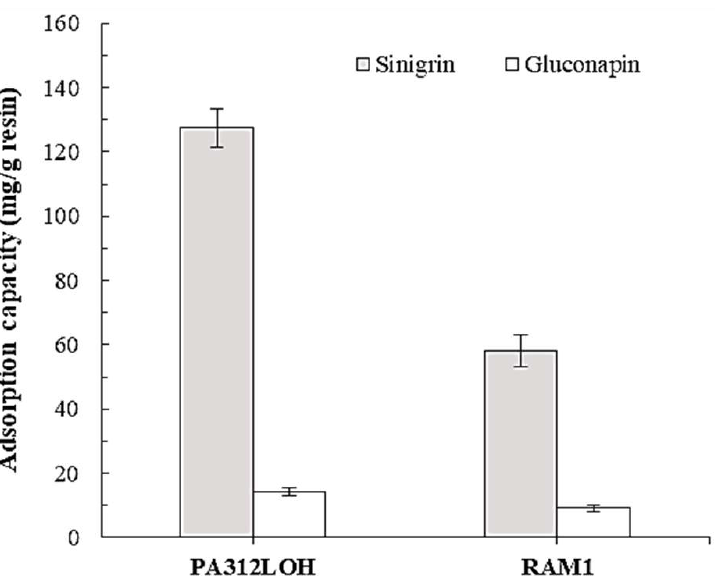
Figure 4. Impact of the resin type on the final adsorption capacity of sinigrin and gluconapin. In order to better characterize the interactions between the resins and the adsorbed glucosinolates, the PA312LOH resin was characterized by FTIR before and after adsorption and at the end of the desorption step. The obtained spectra are presented in Figure 5. It can be observed that the functional group –N+(CH 3 ) 3 is displayed by the spectral band around 885 cm − 1 . Its presence can also clearly be identified thanks to vibrations of the O-H bond linked with the quaternary charged nitrogen as N+(CH 3 ) 3 -OH - . Before the adsorption (new resin before use), O-H stretching and bending vibration were represented, respectively, by the broad band in 3100–3500 cm − 1 and the band in 1640 cm − 1 . A small peak in 975 cm − 1 related to the O-H deformation vibration was also an indicator of the hydroxyl group. After the adsorption, these peaks and particularly the band 3100–3500 cm − 1 were decreased significantly, indicating that most of O-H groups were replaced by the adsorbed sinigrin and gluconapin. Moreover, the peak of the adsorbed sinigrin could be found with peaks in 1060 cm − 1 and 1270 cm − 1 , as compared with the standard of sinigrin. After desorption, these peaks were significantly decreased, confirming the desorption of